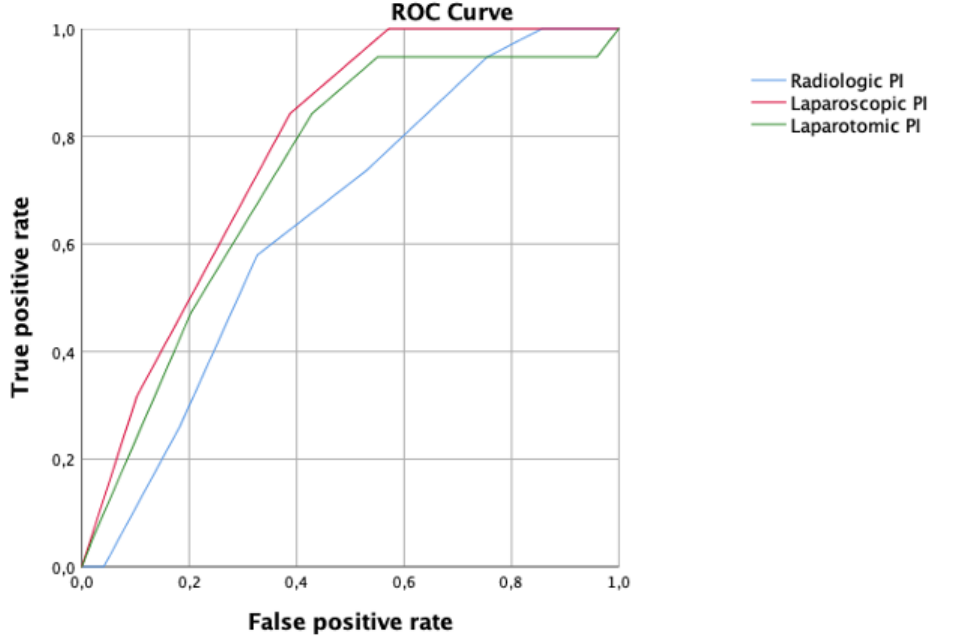
Figure 3. Receiver operating characteristic (ROC) curve comparing radiologic (blue line), laparoscopic (red line), and laparotomic (green line) predictive index (PI) in women who underwent primary debulking surgery.